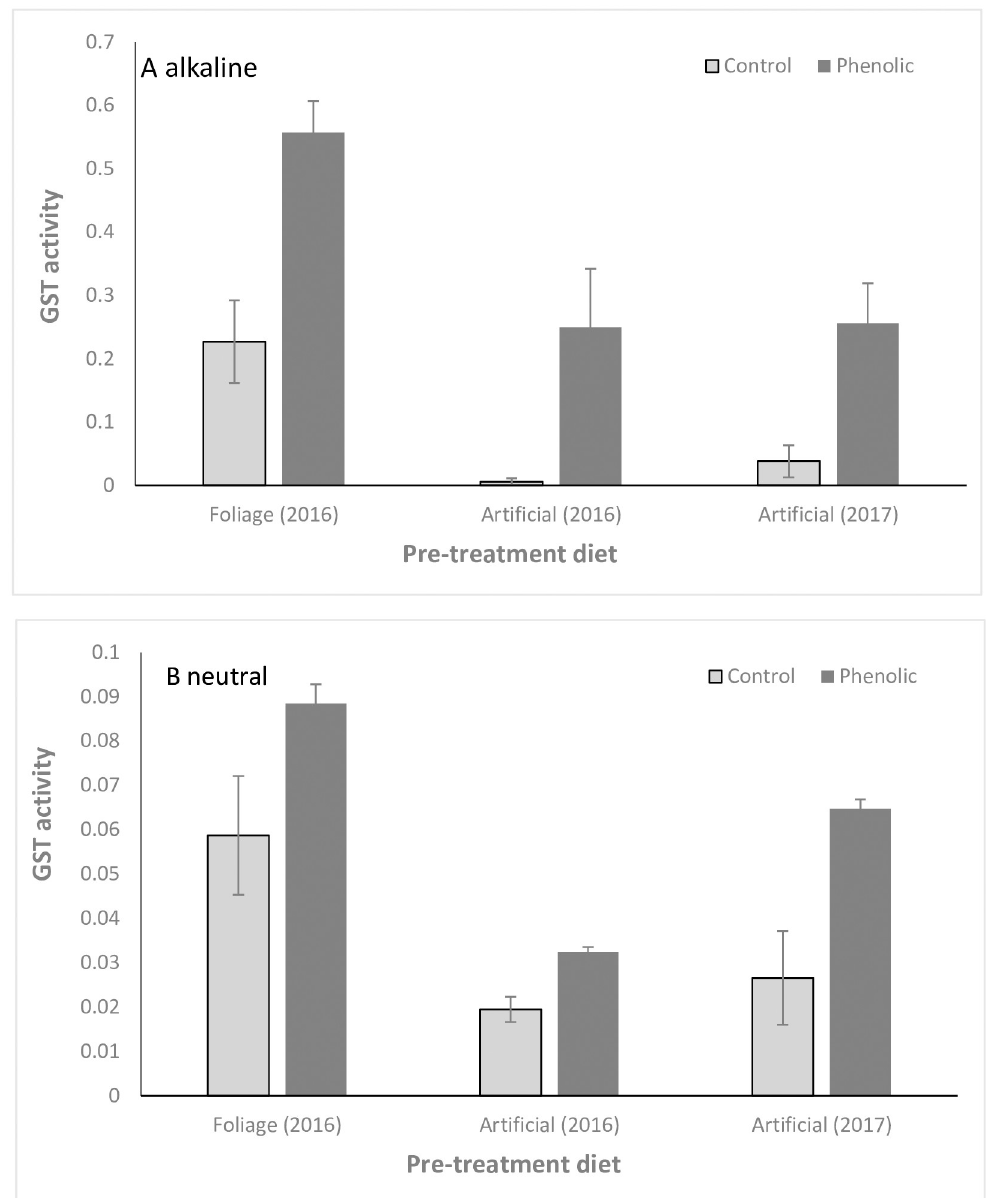
Fig 4. GST activity. Glutathione-S-transferase enzyme activity of spruce budworm midgut tissue at neutral and alkaline pH, represented per mg soluble protein (mean ± SE, N = 12).